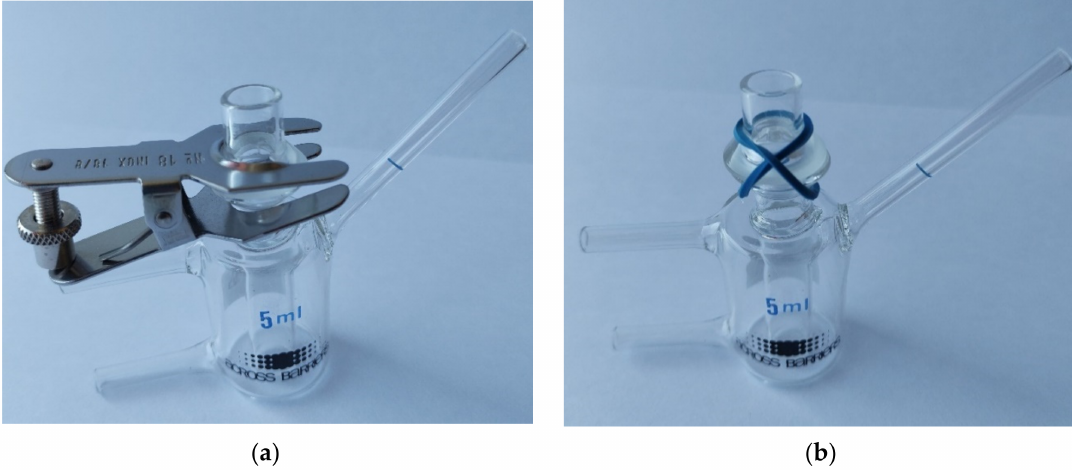
Figure 5. ( a ) Standard Franz cell with metal clip; ( b ) Franz cell fastened with an elastic band suitable for application with alternating magnetic field.